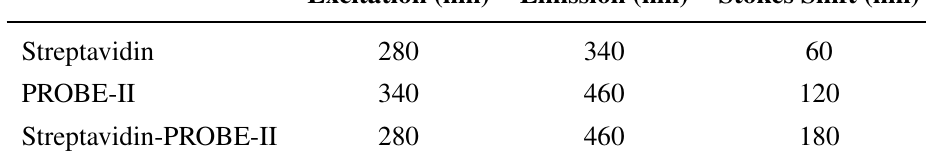
Intrinsic tryptophan fluorescence as the FRET donor with coumarin-based PROBE-II